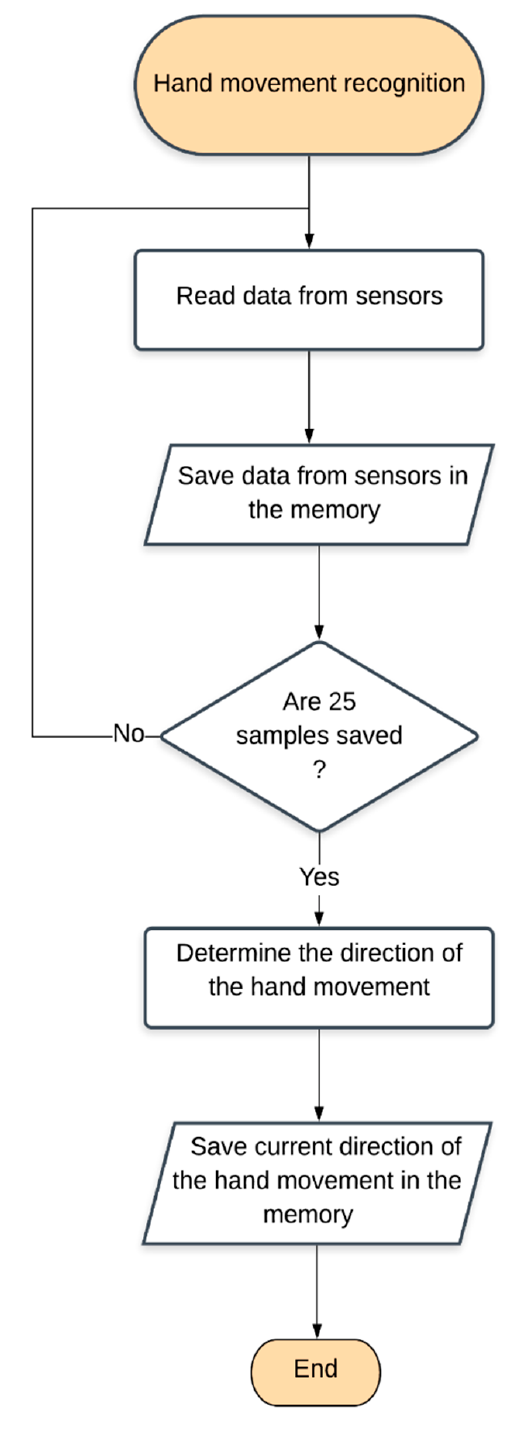
Figure 5. Recognition of hand movement algorithm.